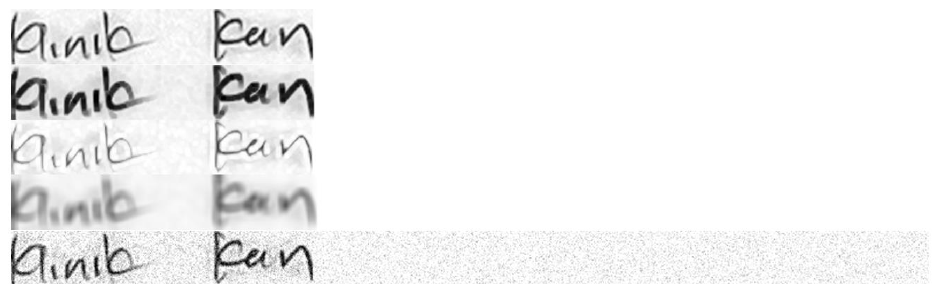
Figure 5. Samples of segmented and augmented images.